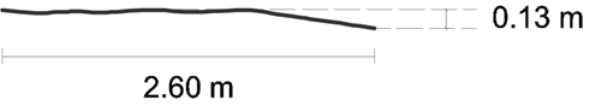
Fig.7: Cross sections extracted along the bands of acquisition by manual